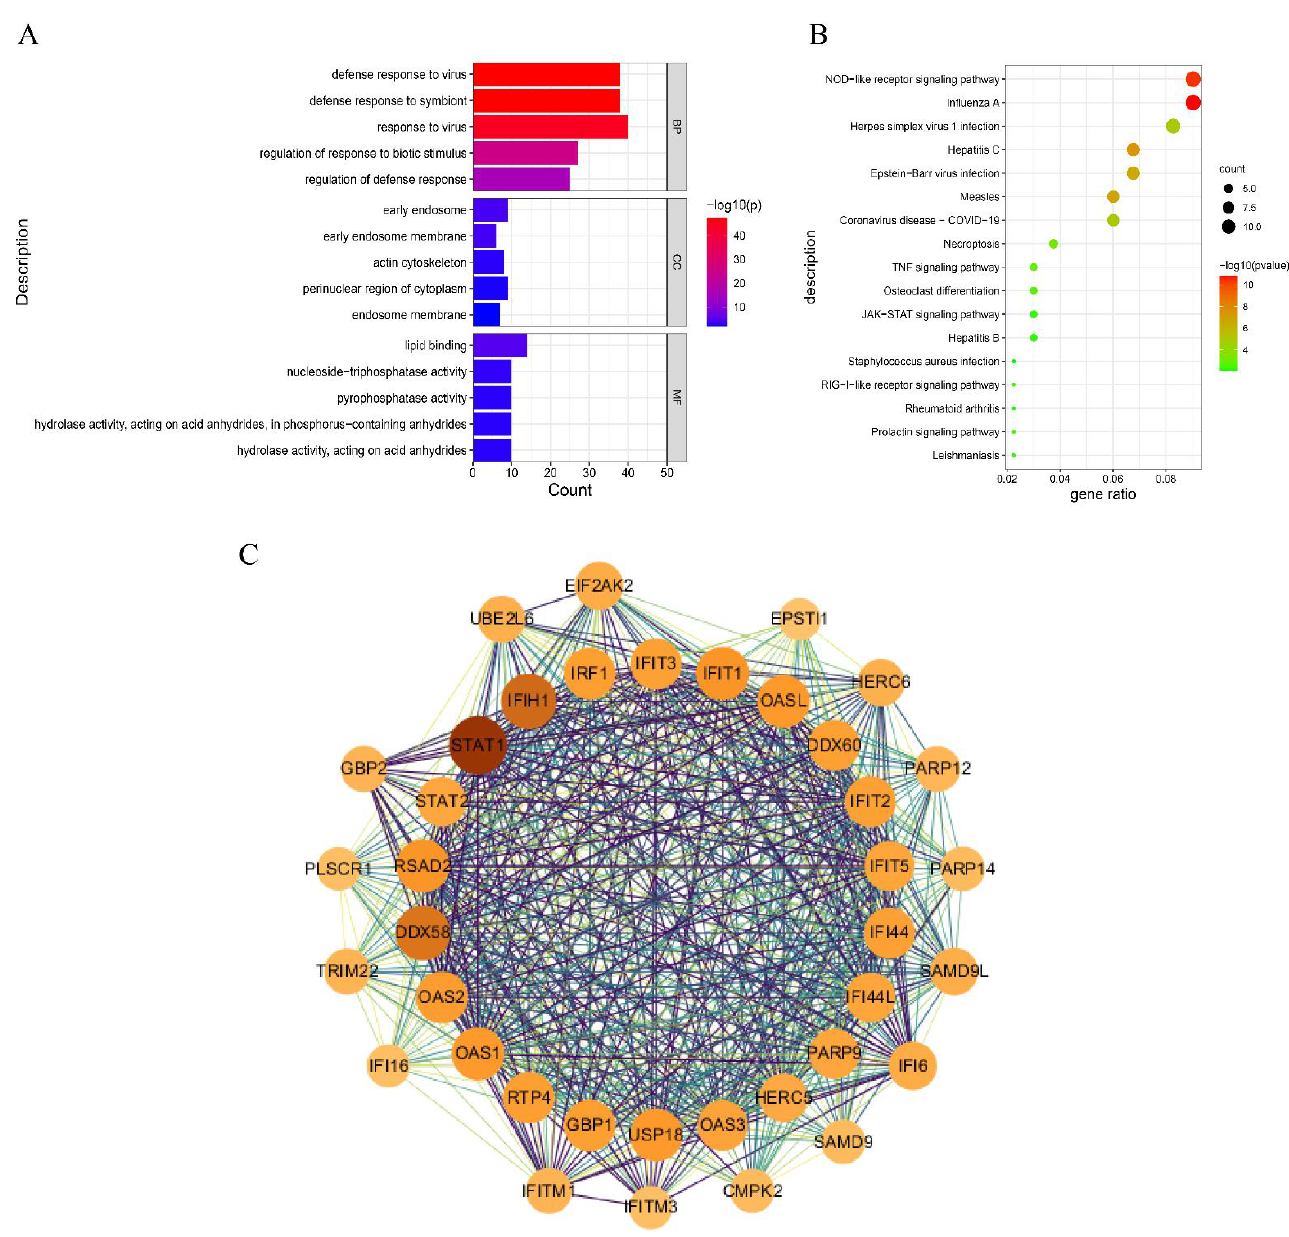
Figure 5. Functional enrichment analysis of DEHERV-G pair genes and PPI networks. GO analysis ( A ) and KEGG analysis ( B ) of DEGs with the top five biological processes (BPs), cell components (CC), and molecular function (MF) with the lowest P value (P < 0.05) of GO analysis included. The color of columns or bubbles represents the P value, and the length of the column or the size of the bubbles represents the number of counts. ( C ) PPI core networks of human genes. Circles represent protein-coding genes, and the darker the circle, the more genes are associated.